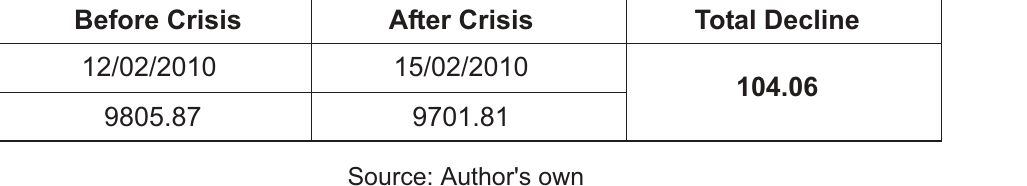
Table- 2 The status of KSE-100 index before and after the Executive-Judiciary